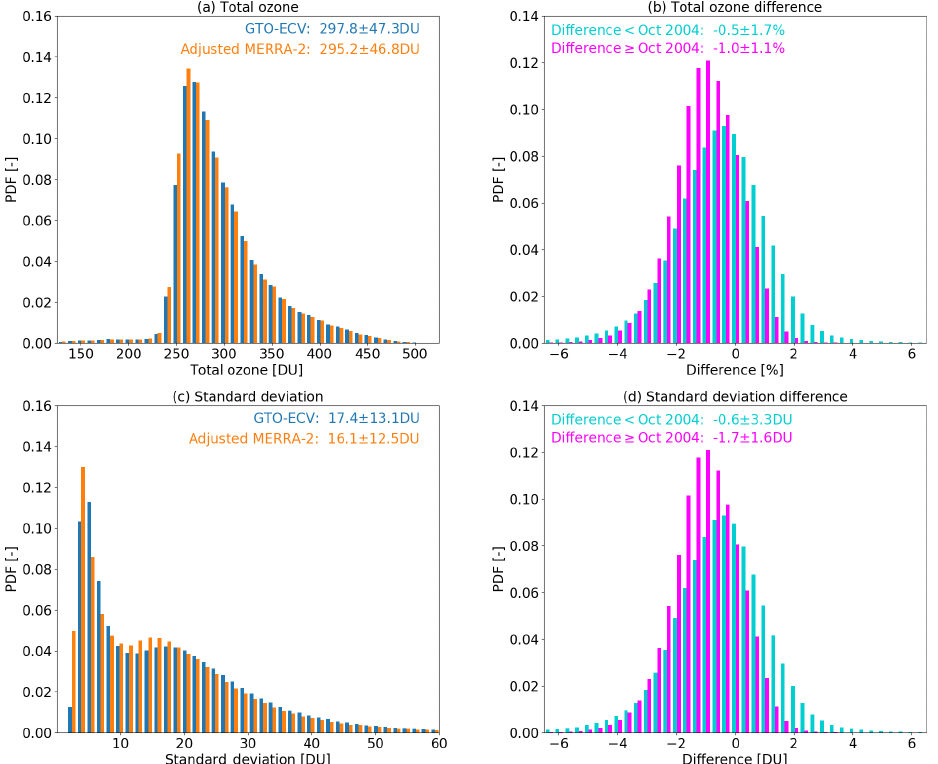
Figure 6. (a) Histograms of total ozone for GTO-ECV (blue) and adjusted MERRA-2 (orange). (b) Histogram of differences (%) in total ozone between adjusted MERRA-2 and GTO-ECV for two different time periods: before October 2004 (turquoise) and after October 2004 (magenta). (c, d) Corresponding histograms for standard deviations (c) and difference in standard deviation (DU) for two periods (d)